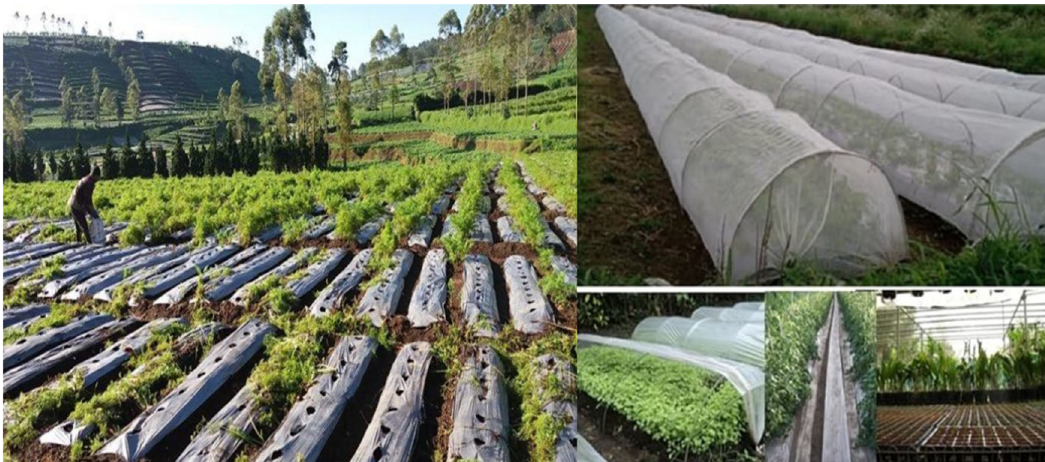
Figure 3. The use of plastic in agriculture in Dieng